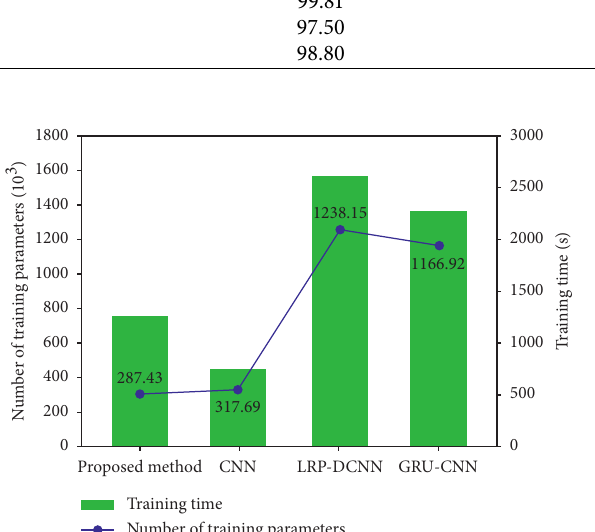
Figure 21: The number of training parameters and the training time of the four